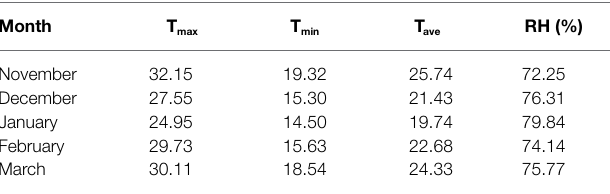
TABLE 1 | Summary of the monthly mean climate condition, maximum (T max ) and minimum (T min ), mean (T ave ) daily temperatures and relative humidity (RH), inside the